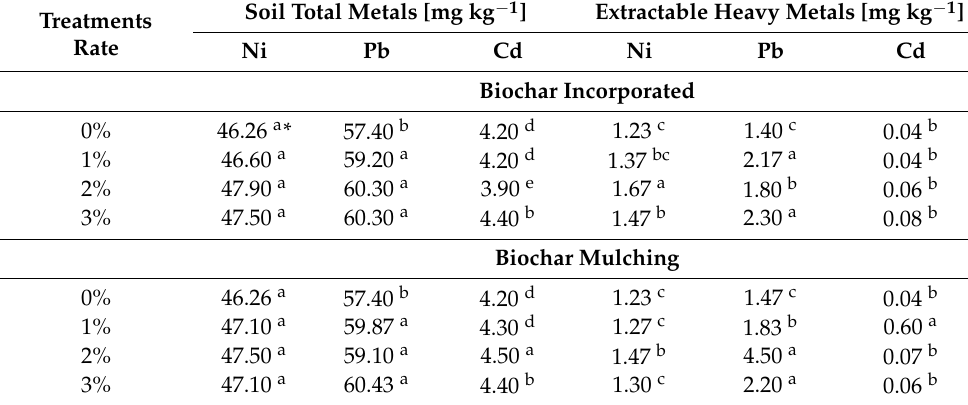
Table 8. Total and extractable heavy metals under the upper 20 cm soil as affected by biochar addition and drainage water irrigation.